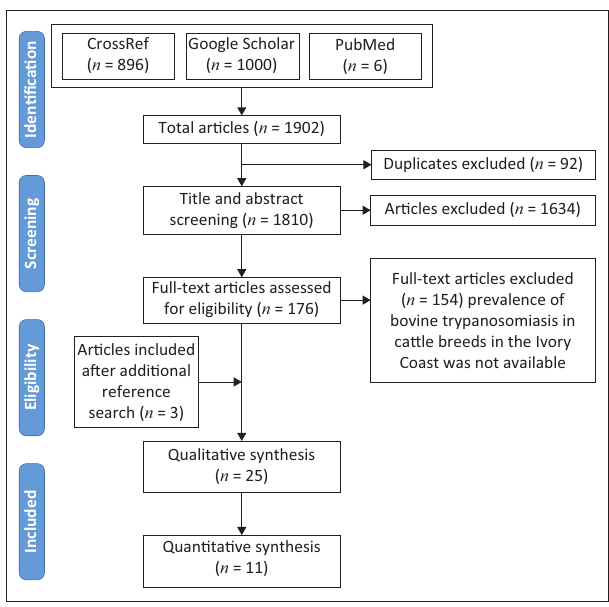
FIGURE 1: Preferred Reporting Items for Systematic Reviews and Meta-Analyses flow diagram of studies’ screening and